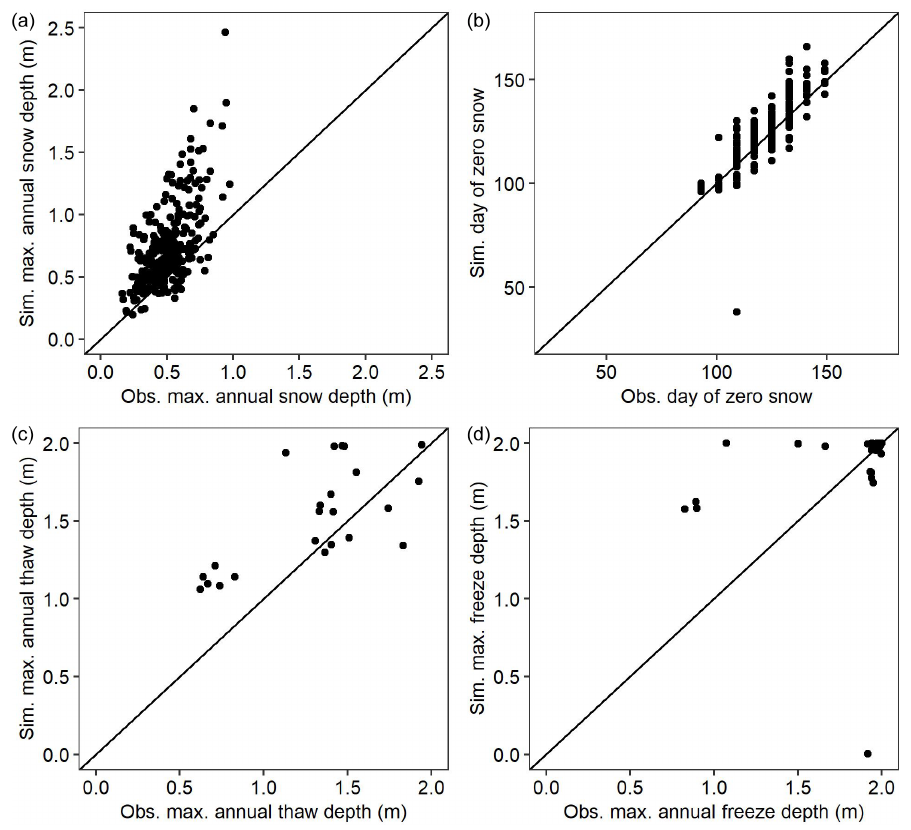
Figure 2. (a) Observed vs. simulated maximum annual snow depth at 17 sites between 2001–2017. (b) Observed vs. simulated day of spring snowmelt at 17 sites between 2001–2017. (c) Observed vs. simulated maximum annual thaw depth at seven sites underlain by permafrost between 2014–2018 (only site years with complete observational records are included). (d) Observed vs. simulated maximum annual freeze depth at 10 sites not underlain by permafrost between 2014–2018 (only site years with complete observational records are included). Black lines show one-to-one relationships in all